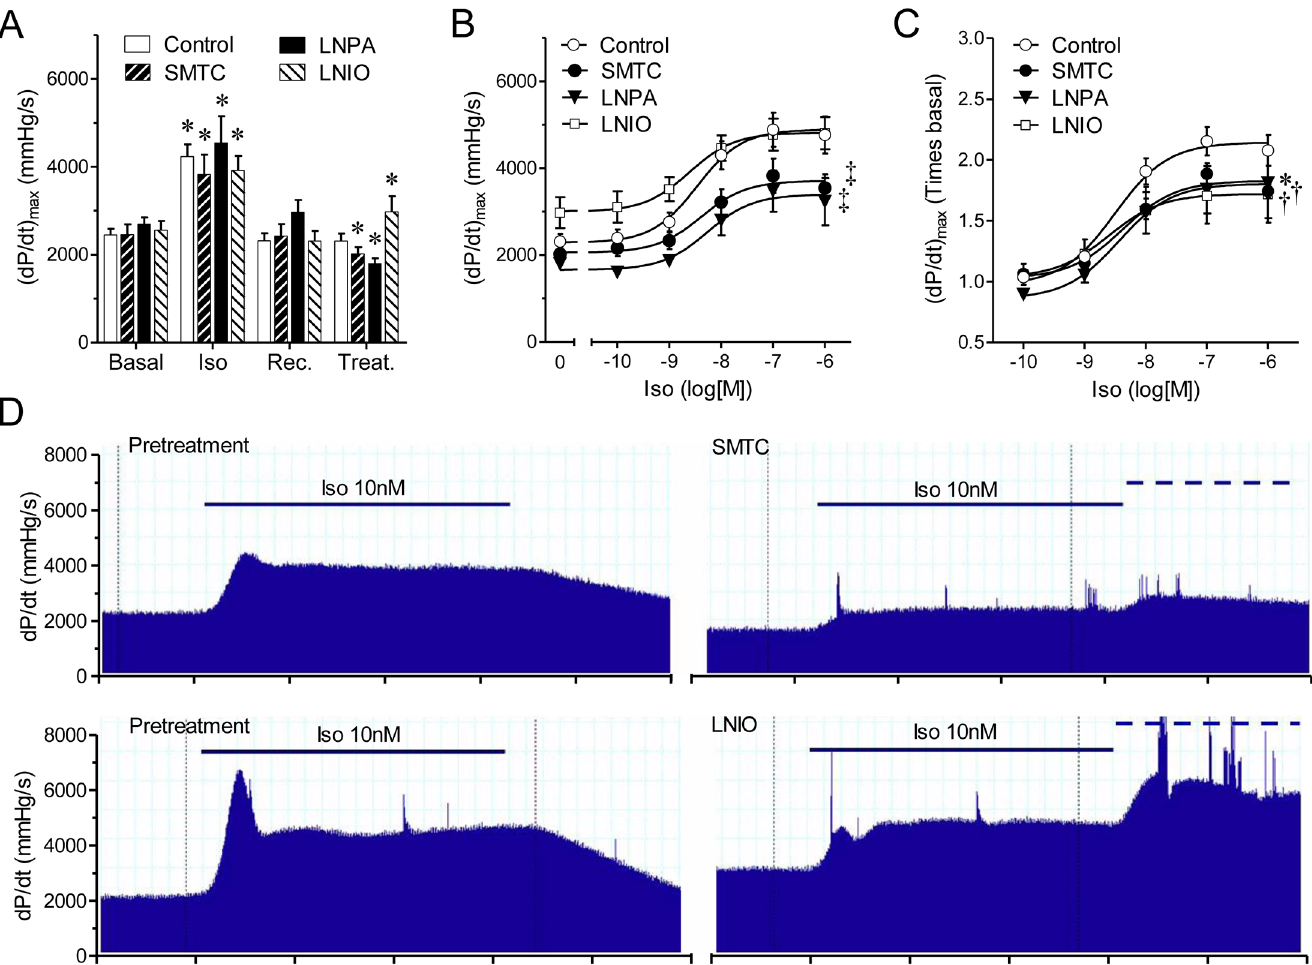
Fig 1. NOS-1 inhibition reduces the inotropic response to β -adrenergic stimulation. (A) Contractility (dP/dt max ) values obtained consecutively under basal conditions (Basal), stimulation with isoproterenol (10nM, 3-min) (Iso); recovery after 10-min washout of the agonist (Rec.), and after 20-min treatment (Treat.) with vehicle (Control, n = 14), or NOS-1 inhibitors L-Methyl-thio-citrulline 300nM (SMTC, n = 8), or N ω — propyl — L — arginine 200nM (LNPA, n = 6), or NOS-3 inhibitor L-N 5 -(1-Iminoethyl)ornithine 1 μ M (LNIO, n = 6). Asterisk indicates p < 0.05 vs. respective Basal (paired t test, with Dunnett ’ s modification). (B) Accumulative concentration-response curves to isoproterenol in absence (Control) or presence of NOS-1 inhibitors SMTC or LNPA, or NOS-3 inhibitor LNIO ( ‡ p < 0.001 vs. Control curve, best fit ANOVA, the difference resided only in the top value; bottom and EC 50 parameters were shared). (C) Same data as in panel B, expressed as relative values, corrected by the corresponding contractility values after treatment with inhibitor. ( * p < 0.05 (LNPA), † p < 0.01 (SMTC, LNIO) vs. control curve; the difference resided in the top value). (D) Representative records showing contractility (dP/ dt) responses elicited by application of Iso10nM (solid line) before and after treatment with SMTC (top) and LNIO (bottom). The dashed line indicates application of 100nM Iso as part of the dose-response